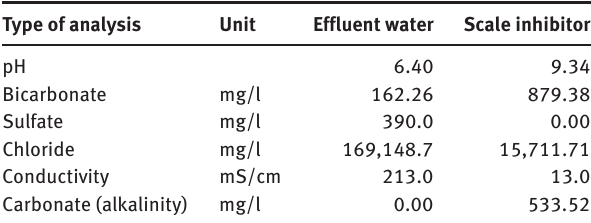
Table 1: Properties of the media used for the chemical aging studies.